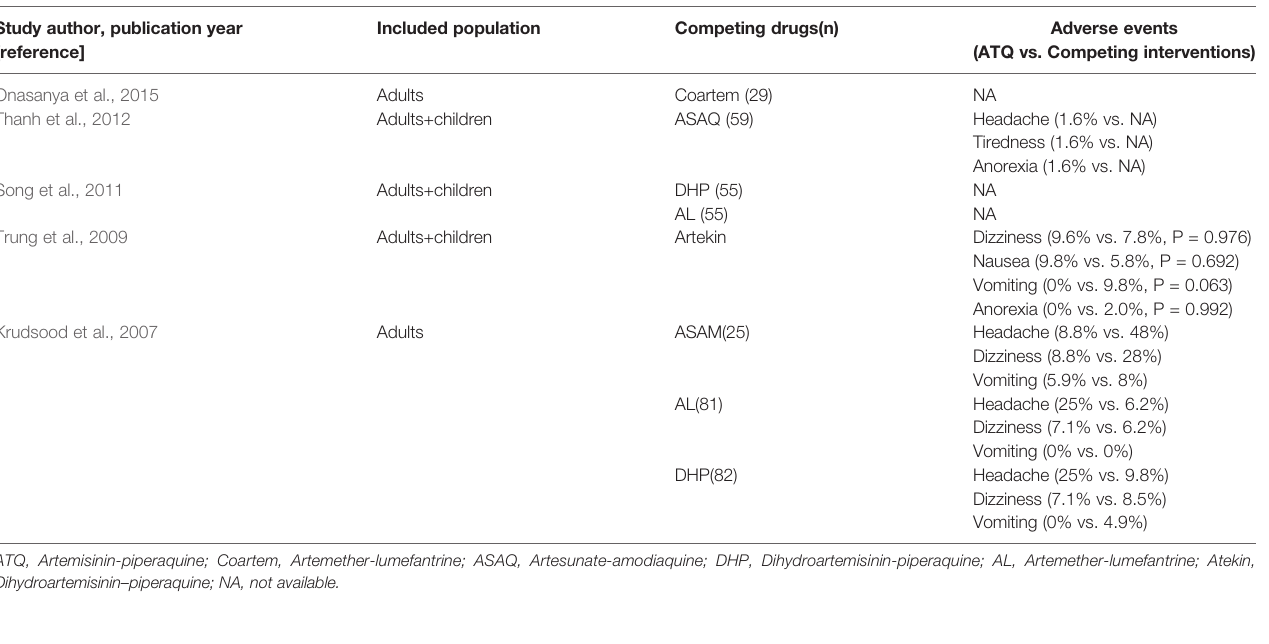
TABLE 4 | Comparison of adverse events of included trials.